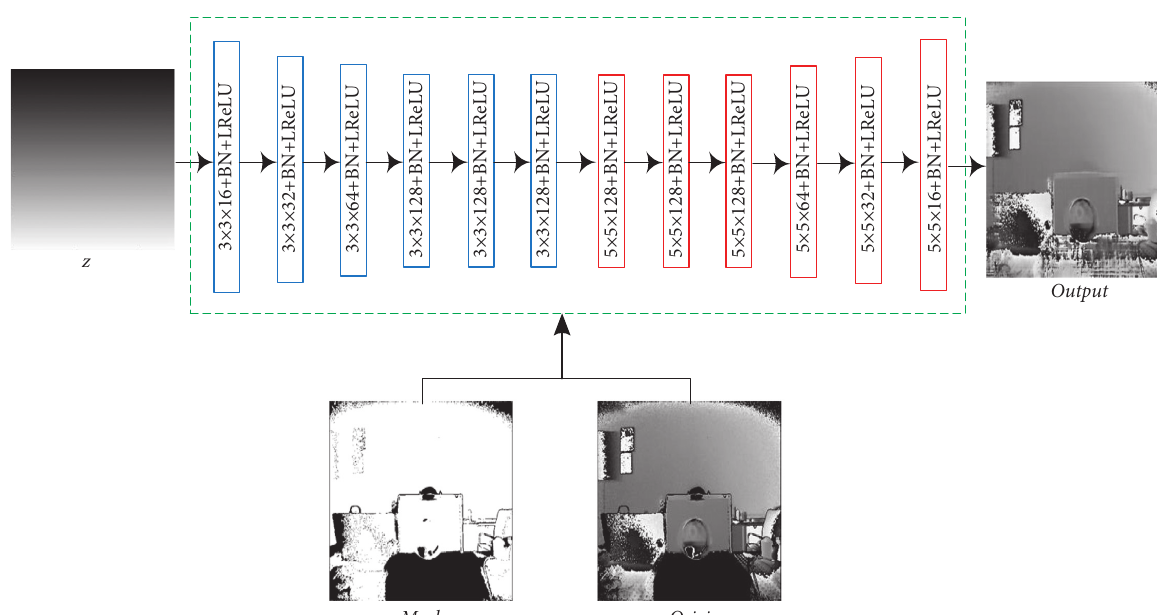
Figure 6: The network structure of the depth map patching algorithm.